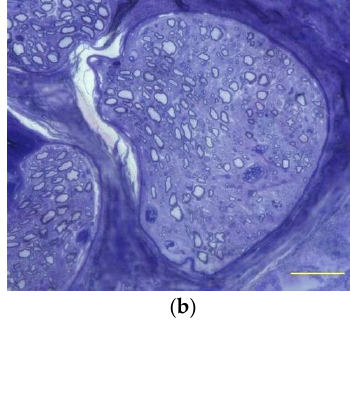
Figure 6. Evaluation of retrograde tracing. Microscopic image of ectopic ganglion after the injection of Fluoro-Gold and immunohistochemical staining. ChAT, choline acetyltransferase. Scale bar = 50 µm.